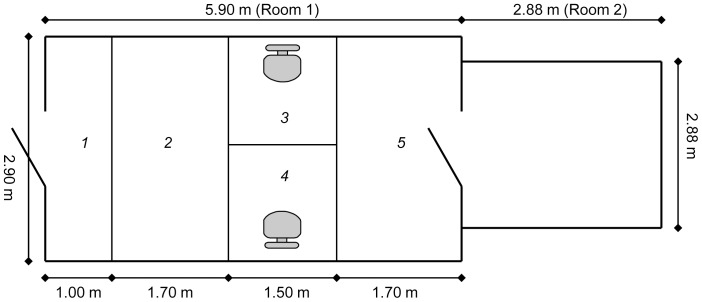
Overview of the test area.The black lines represent the tape on the floor that divided the larger room (room 1) into five zones (1: Near entrance door, 2: Neutral zone, 3 and 4: familiar person's/SA's zone and stranger's/SB's zone each containing a chair, 5: Neutral zone containing a rope tug-toy). The entrance door is at the left hand side of the figure and there is a door between room 1 and room 2 shown to the right in the picture. Room 2 was empty and was available to the dogs from episode 4.